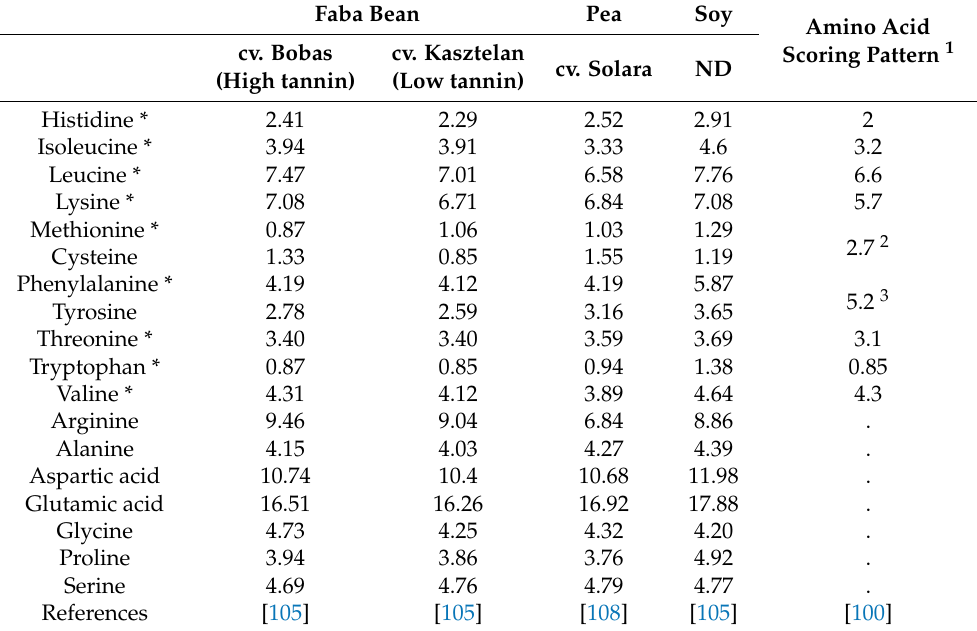
Table 2. Amino acid profiles of whole faba bean seeds compared to pea and soy. Faba Bean Pea Soy